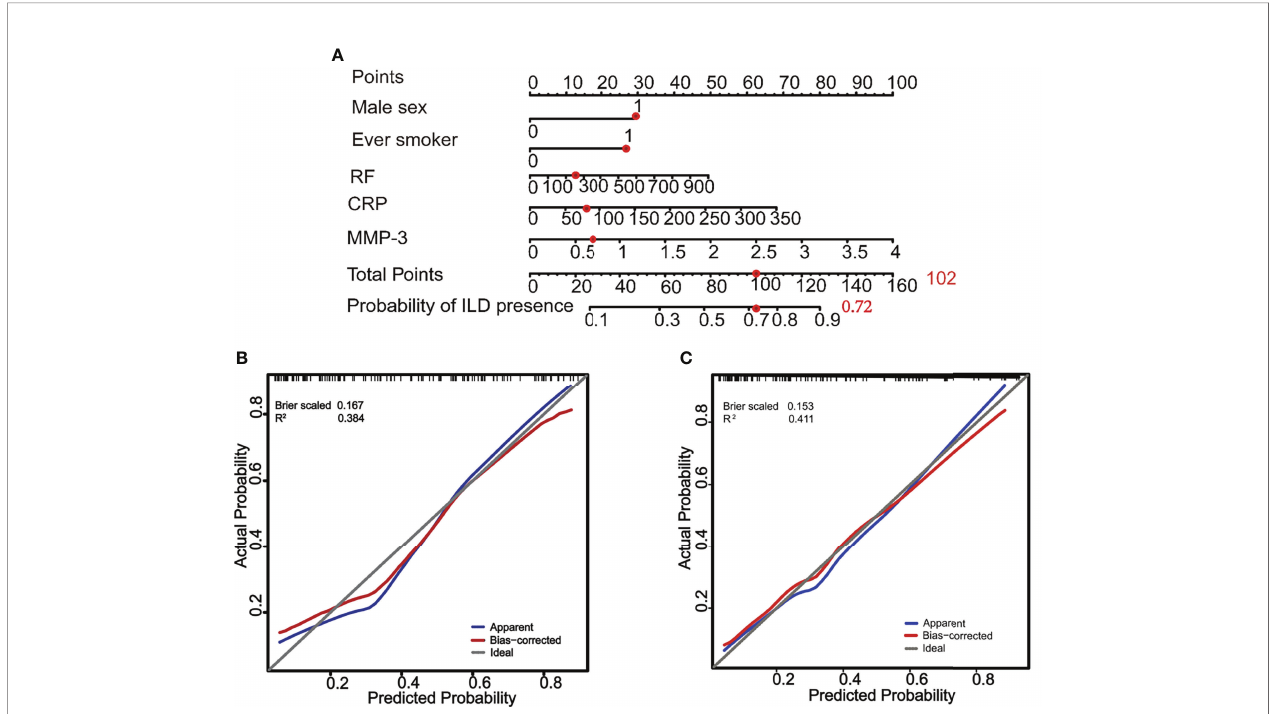
FIGURE 5 | A constructed nomogram for identi fi cation of ILD and its diagnostic performance in RA patients. (A) a nomogram to estimate the risk of ILD presence of a RA patient (male, smoker, RF = 256 IU/ml, CRP = 82 mg/dl, and MMP-3 = 0.66 ng/ml). To use the nomogram, the sum [30 (male) + 28 (smoker) + 12 (RF) + 14 (CRP) + 18 (MMP-3) = 102] of these points is located on the Total Points axis, and a red dot is drawn downward to the probability of the ILD presence axis to determine the presence (72%) of ILD. (B) The calibration curve of probability of ILD presence for RA patients in training cohorts. The x-axis and y-axis represent the nomogram-predicted probability and the actual probability of ILD, respectively. Perfect prediction would correspond to the slope of gray line that makes a 45° angle. The blue line represents all cohorts (n = 122), and the red line expresses bias correction by bootstrapping (B = 1,000 repetitions), indicting the perfect agreement between the presence of ILD and the risk prediction by the nomogram. (C) The calibration curve of the probability of ILD presence for RA patients in validation cohorts. The x-axis and y-axis represent the nomogram-predicted probability and the actual probability of ILD, respectively. Perfect prediction would correspond to the gray line with a 45° angle. The blue line represents all cohorts (n = 101), and the red line expresses bias correction by bootstrapping (B = 1,000 repetitions), indicting the perfect agreement between the presence of ILD and the risk prediction by the